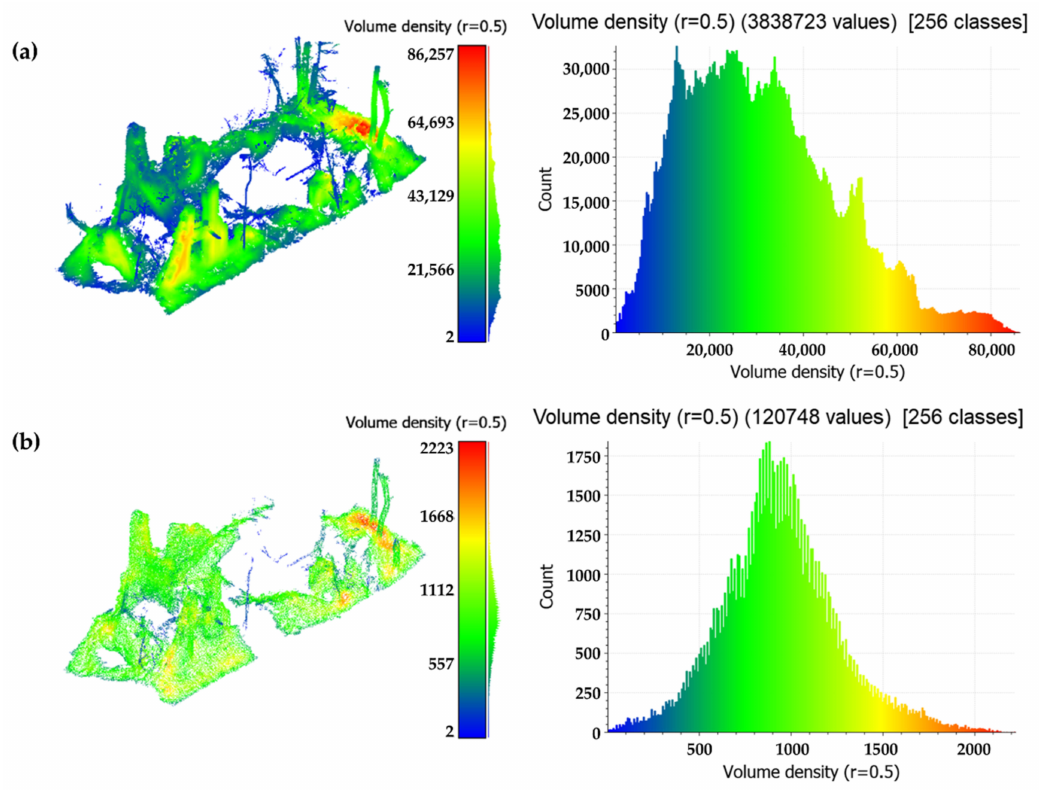
Figure 16. Point cloud density of TLS data and relative histogram ( a ) with respect to L1 data ( b ). Table 6. Volume density and number of neighbors comparison in a volume of 1 m 3 between